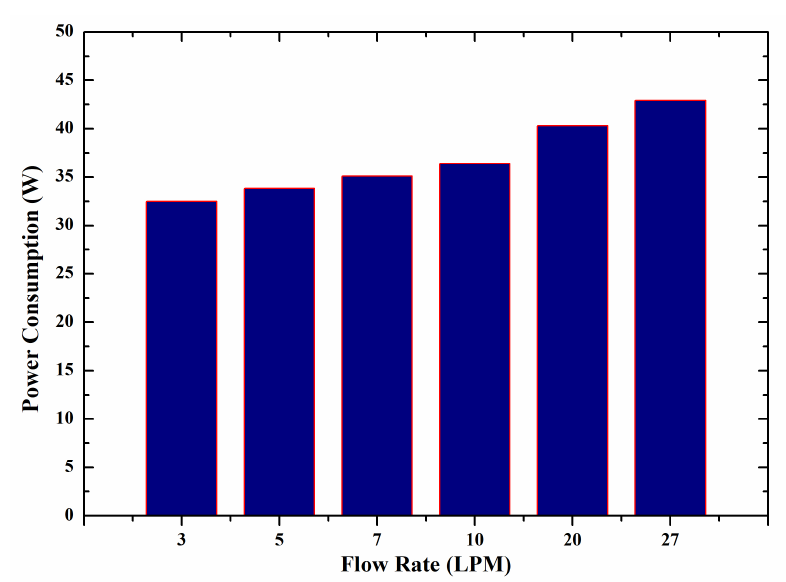
Figure 14. Pump power consumption against flow